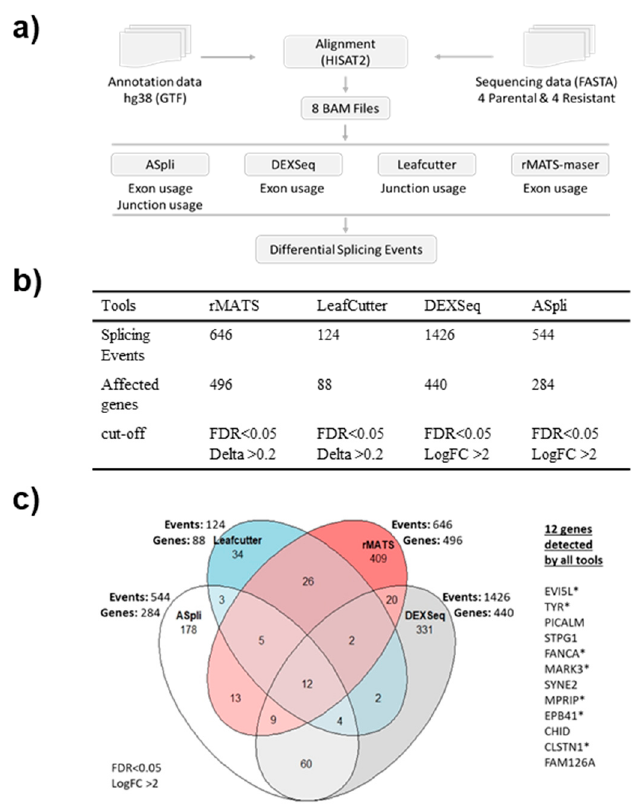
Figure 3. Results of four differential splicing analyses. ( a ) Workflow of the analysis with the four different tools. ( b ) Table showing the number of detected splicing events, affected genes, and cut- offs used for each tool. ( c ) Venn diagram showing the number of splicing events and affected genes for each tool and list of the 12 genes detected by all tools. * indicates the genes selected for further validation.